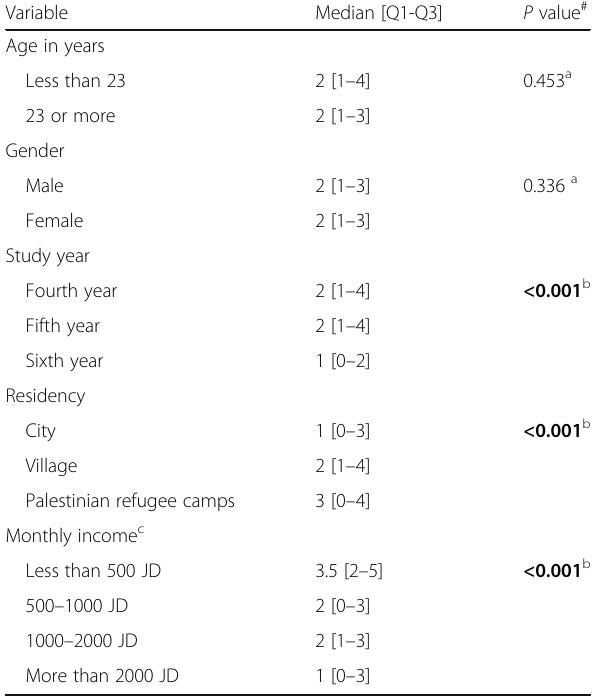
Table 3 Relationship between characteristics of participants